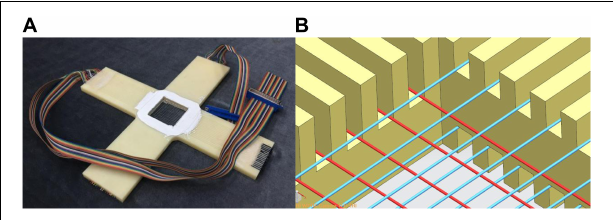
FIGURE 4 | (A) The picture of WMS. (B) The detail of the three layers structure.